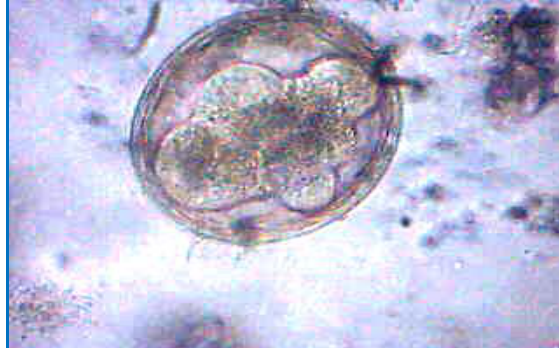
Figure, b: Uncinaria sp. egg in stray dogs.